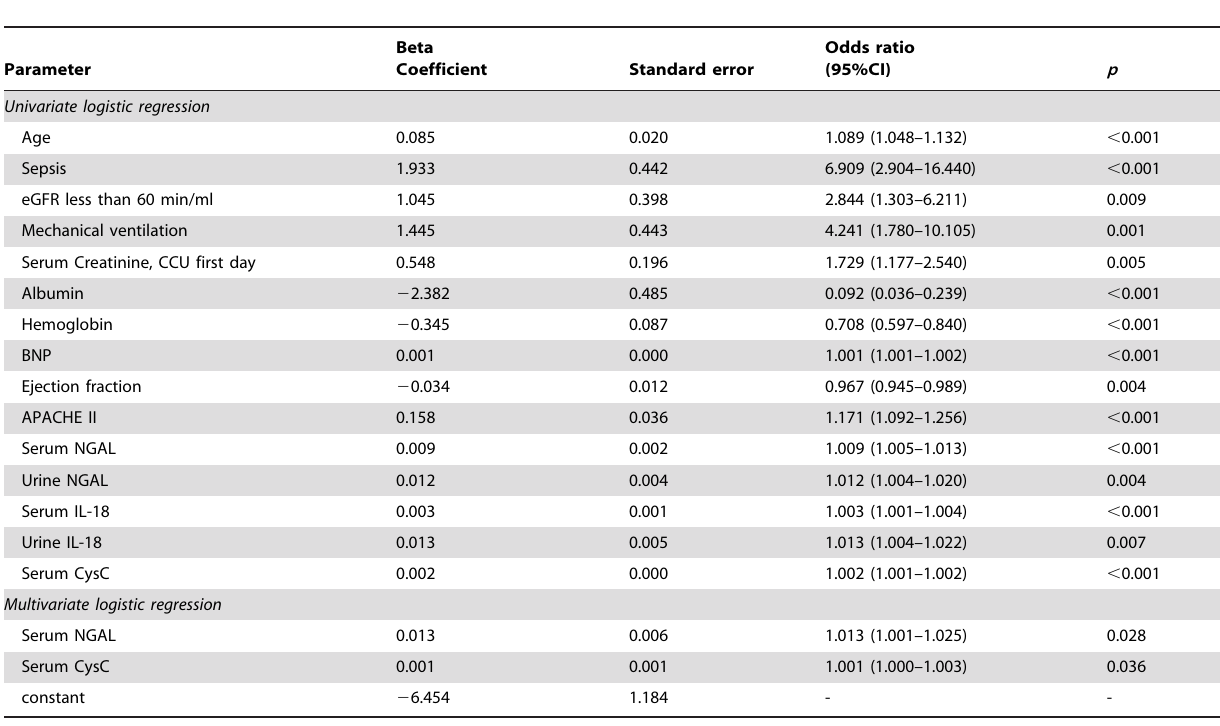
Table 3. Logistic regression analysis for AKI, according to baseline prognostic factors on the first day of CCU